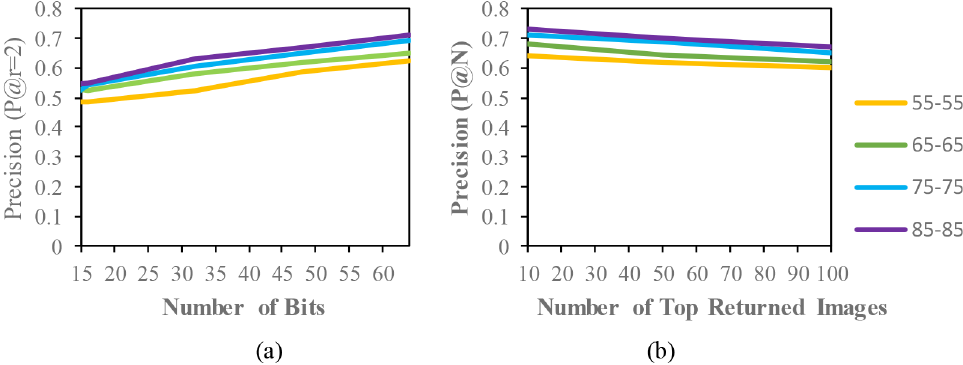
Figure 4. Comparison of the (a) precision curves at a Hamming radius of 2 (P@r = 2) with different bit lengths and the (b) precision curves of the top-N returned images on the OUISIR-LP dataset.